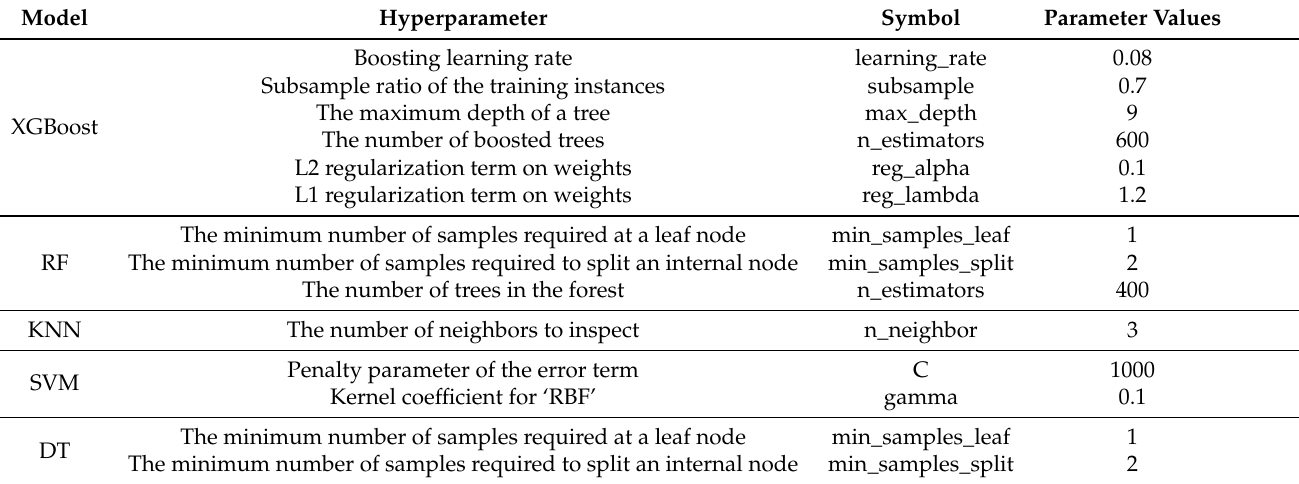
Table 2. Main hyperparameters tuned for parametric